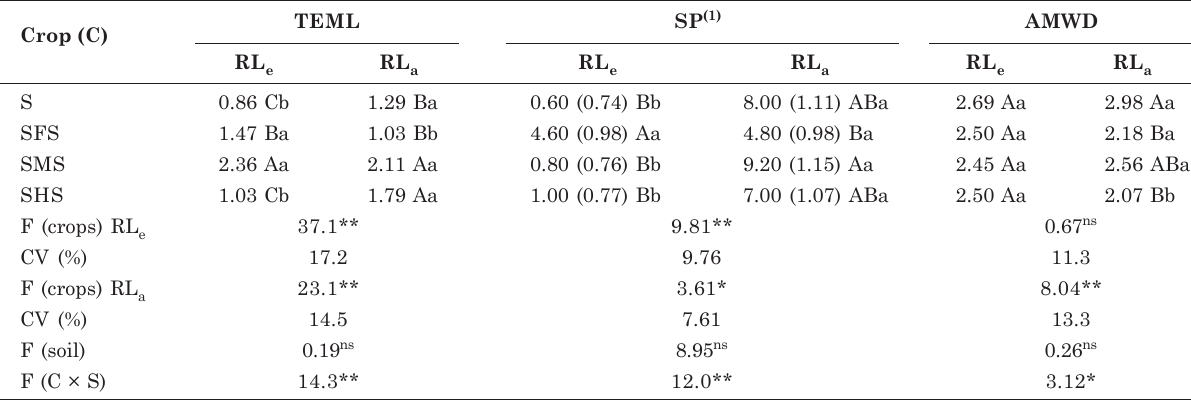
S: soybean, SFS: soybean/fallow/soybean, SMS: soybean/millet/soybean, SHS: soybean/sunn hemp/soybean. Values followed by an identical letter in the same column were not significantly different as per Tukey’s test at α =0.05. ns not significant, ** significant at the p=0.01 level. Table 2. Crop × soil interaction in total external mycelium length (TEML), in spore production (SP) and in RL e and acric Red Latosol - RL a ) after the first sugarcane